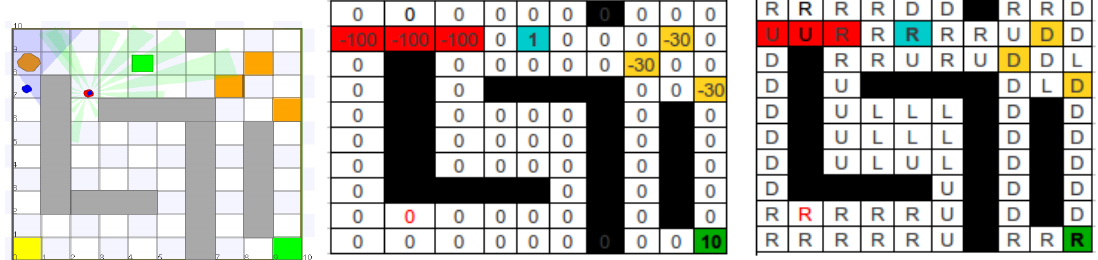
Figure 7. ( left ) Two robots in a simulated navigation area. ( center ) Reward function. ( right ) Optimal navigation policy.